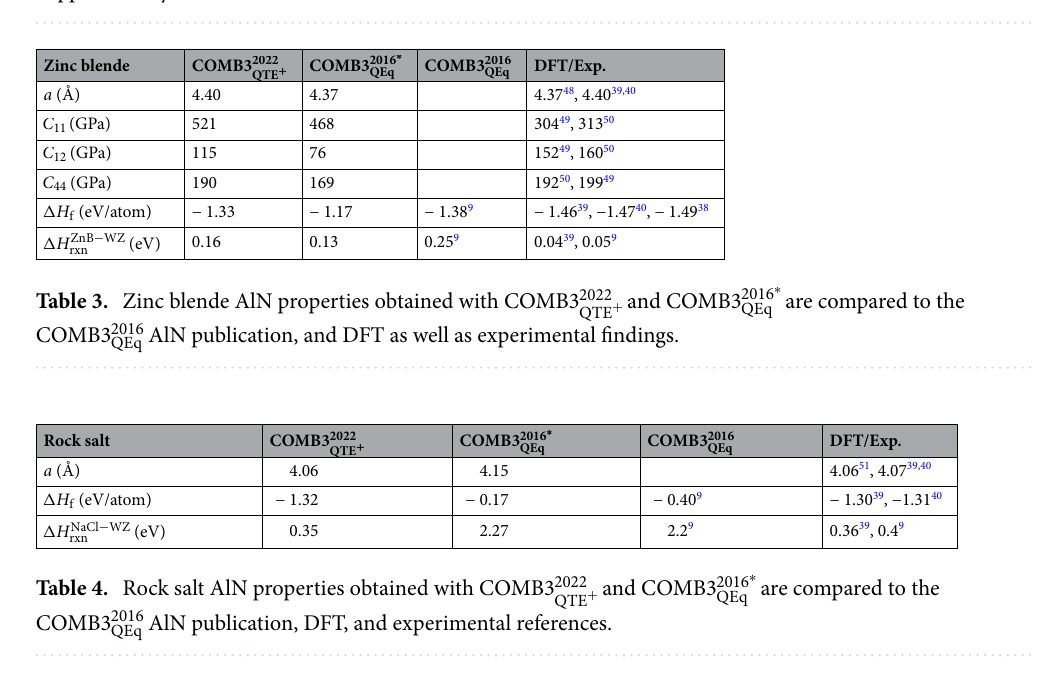
Figure 3. AlN surface energies obtained with COMB3 2022 AlN publication, and DFT as well as experimental findings 9,39,47 . The references are broken down in the Supplementary Tables S2, Table S3, and Table S4.